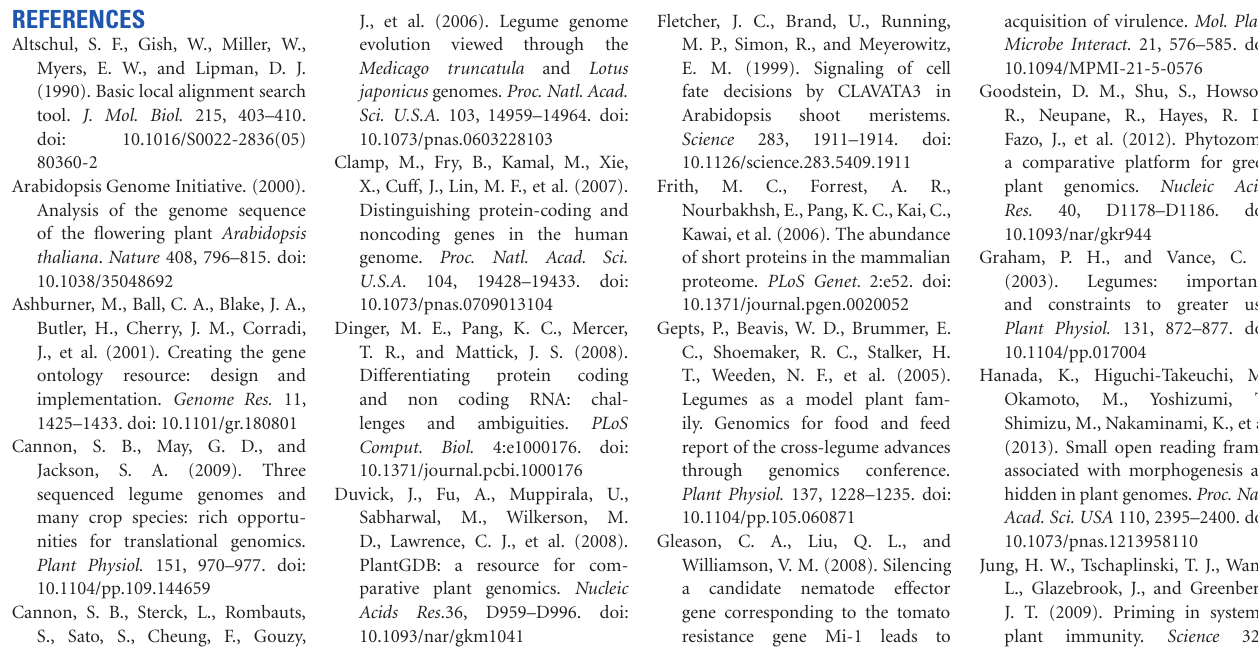
Table S1 | List of sORFs in P. vulgaris and evidences of functionality. Table S2 | Infernal data. Table S3 | Venn diagram data. Figure S1 | GC-content of promoters, ORFs and sORFs in P. vulgaris